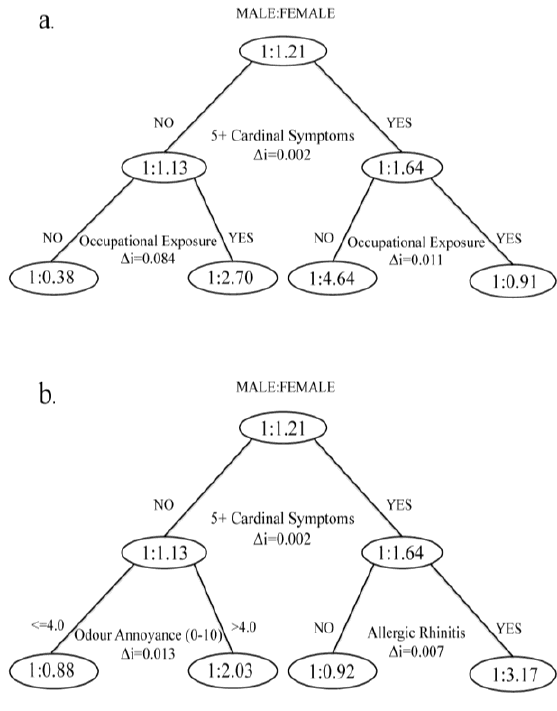
Figure 1. Classification and Regression Tree analysis for sex as dependent variable with 5+ cardinal symptoms forced as the first splitting variable. ( a ) Correctly classified = 71.3%; misclassification risk = 0.287 (SE = 0.015). ( b ) Occupational exposure removed from independent variables; correctly classified = 59.3%; misclassification risk = 0.407 (SE =